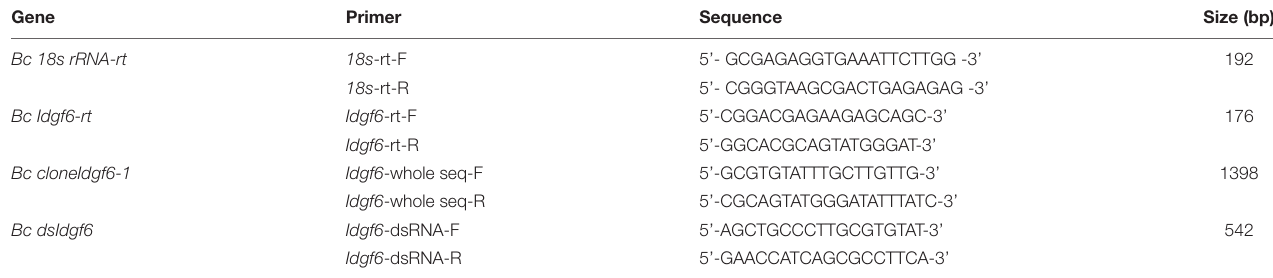
TABLE 1 | Primers used for cloning, real-time qRT-PCR amplification and dsRNA